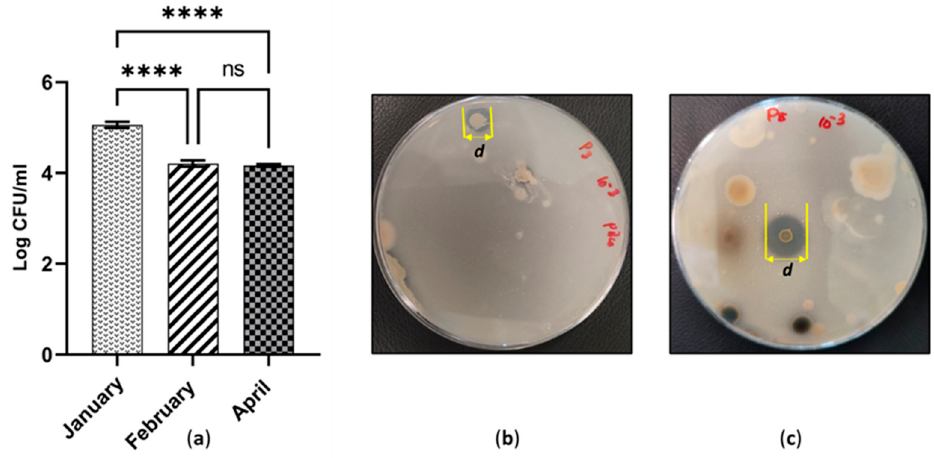
Figure 5. ( a ) Quantity of anaerobic population across cutaway sites in three different time periods; ns, not significant ( p > 0.05); **** p ≤ 0.0001; ( b ) Halozone development due to phosphate solubilisation by PSB isolated in January; ( c ) Halozone development due to phosphate solubilisation by PSB isolated in April.